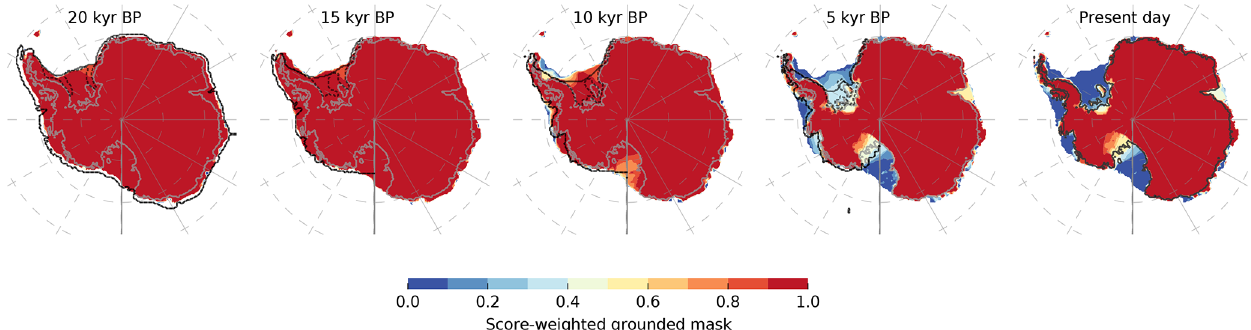
Figure 7. Ensemble-score-weighted grounded mask for 5kyr snapshots. Mask value 1 (red) indicates grounded area which is covered by all simulations, while blueish colors indicate areas which are covered only by a few simulations with low scores (compare Fig. D4 in Pollard et al., 2016). For the last two snapshots, grounding line in the Ross Sea and Weddell Sea sector is found in about 50% of score-weighted simulations inland of its present location (Fretwell et al., 2013, grey line), with some grounding-line re-advance (Kingslake et al., 2018; Siegert et al., 2019). In contrast less than 10% of score-weighted simulations show no grounding-line retreat from glacial maximum extent. Black lines indicate reconstructions by the RAISED consortium (Bentley et al., 2014, Scenario B solid and sce- nario A